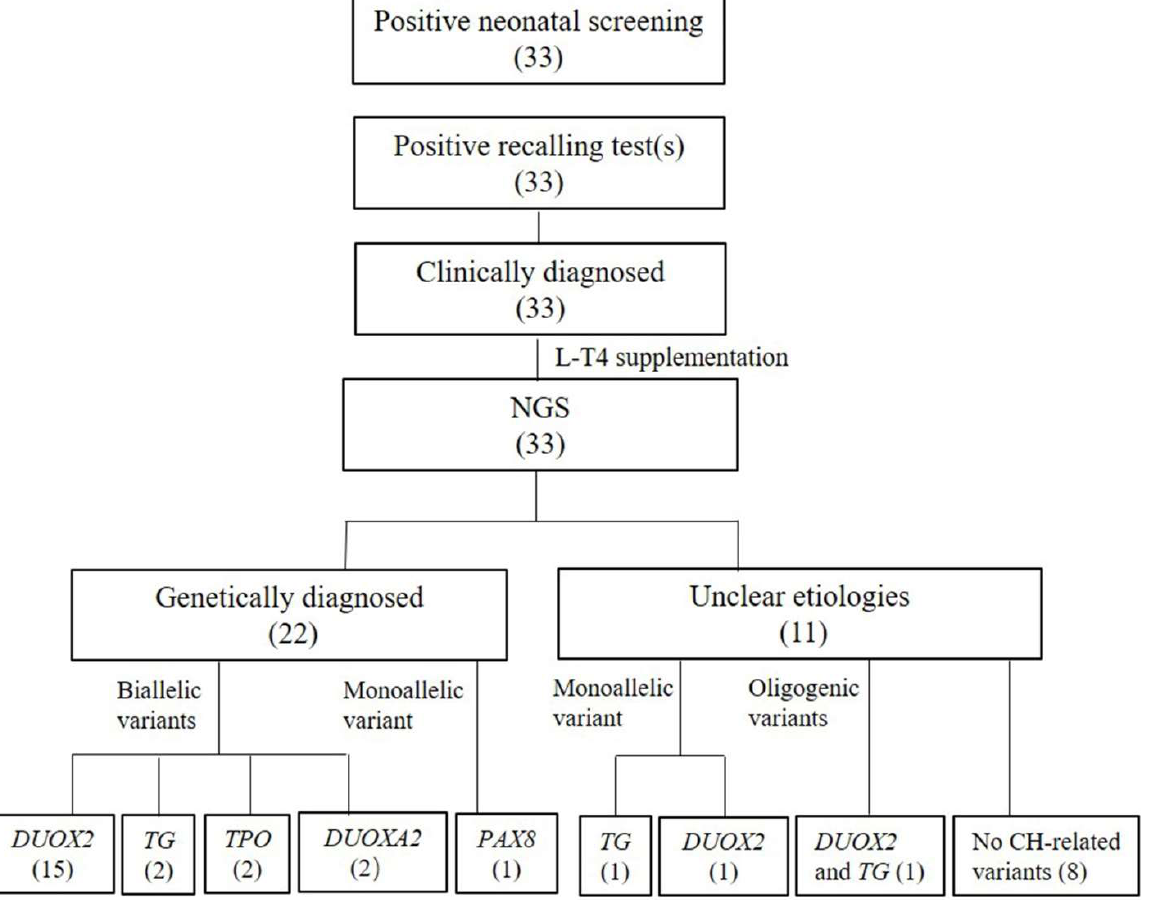
Figure 1. Genetic analytic findings in the 33 CH patients.